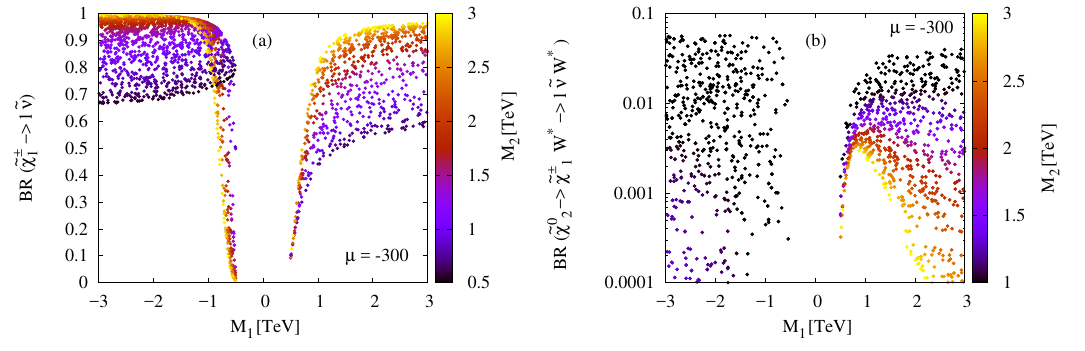
Figure 6 . Variation of the leptonic branching ratios of bino soft mass parameter, M 1 for the Higgsino mass parameter, (cid:22) = (cid:0) 300 GeV. The wino mass parameter M 2 is indicated in the